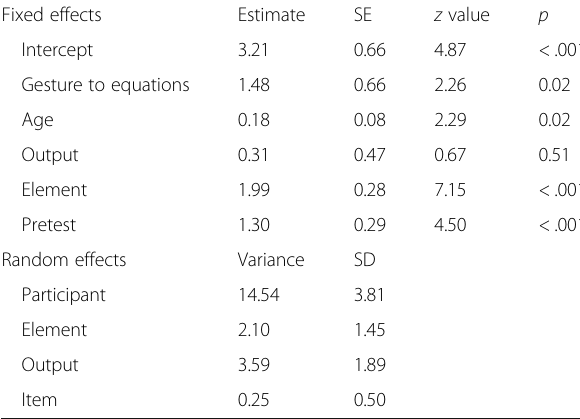
Table 3 Model parameters for the best-fitting model for translation items